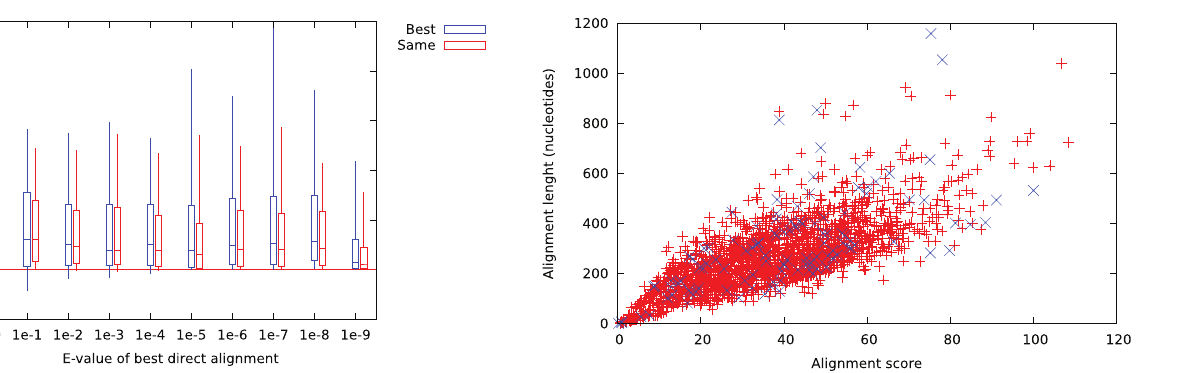
Figure 9. Length and score of transitive alignments for transcripts that had no direct BLAST match. Although not directly comparable, direct alignments with an E -value of 10 { 4 have alignment scores averaging 44.4. Data points marked with as | represent transcripts with an identified Pfam